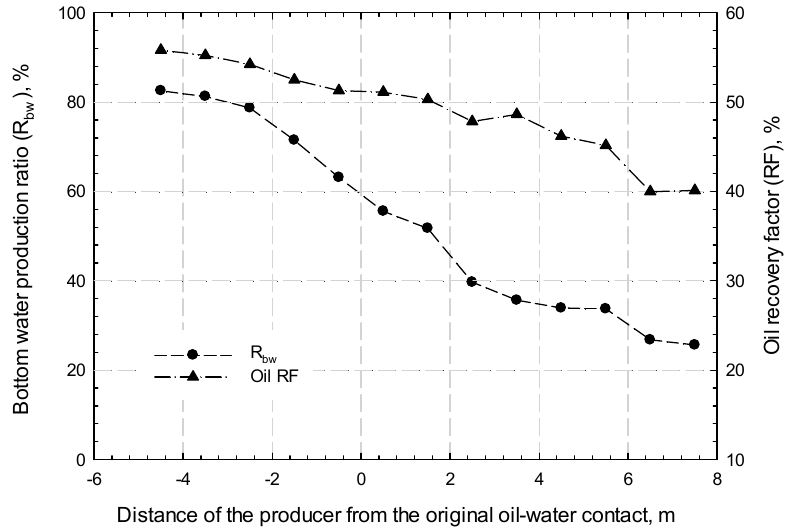
Figure 11. Bottom water production ratio ( R bw ) and oil recovery factor ( RF ) under different well pair locations.